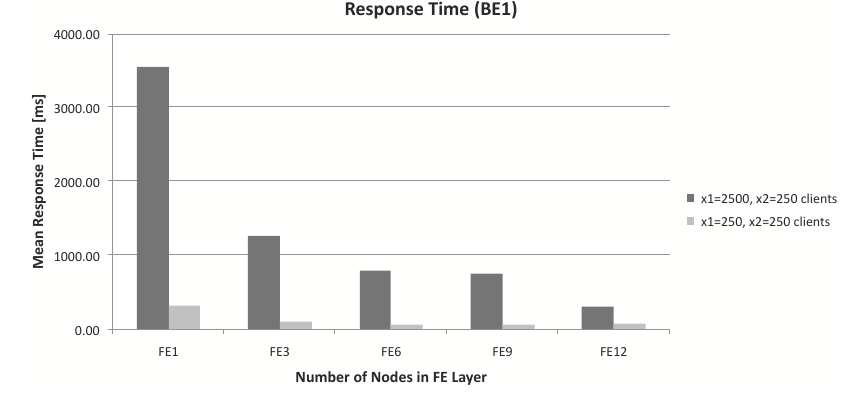
Figure 6. Response time for x 1 = 2500 clients (BE1).